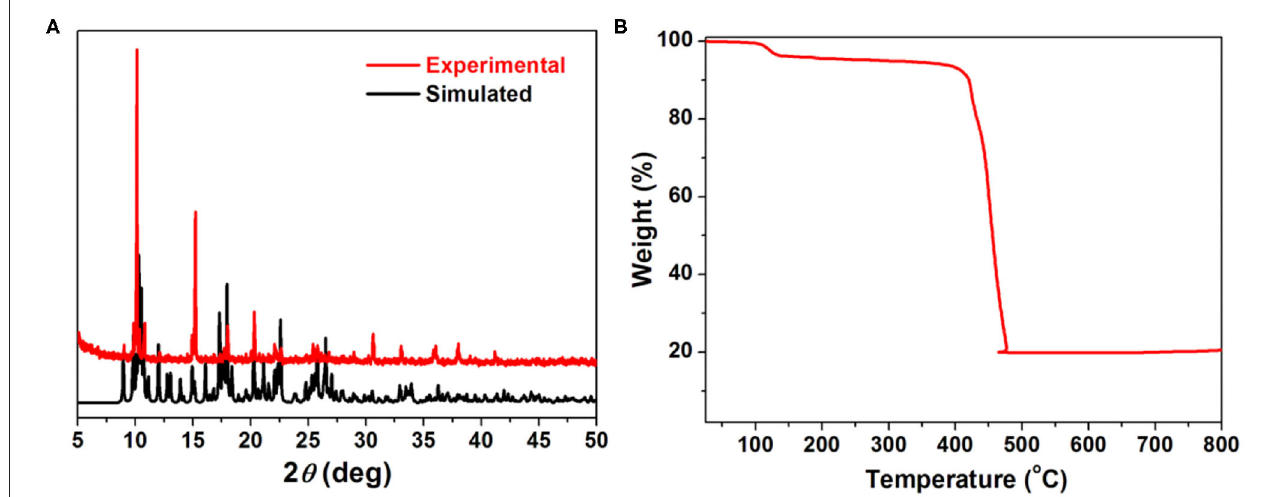
FIGURE 2 | (A) PXRD patterns of simulated (black) and as synthesized 1 (red). (B) Thermo gravimetric analysis curve of 1 .